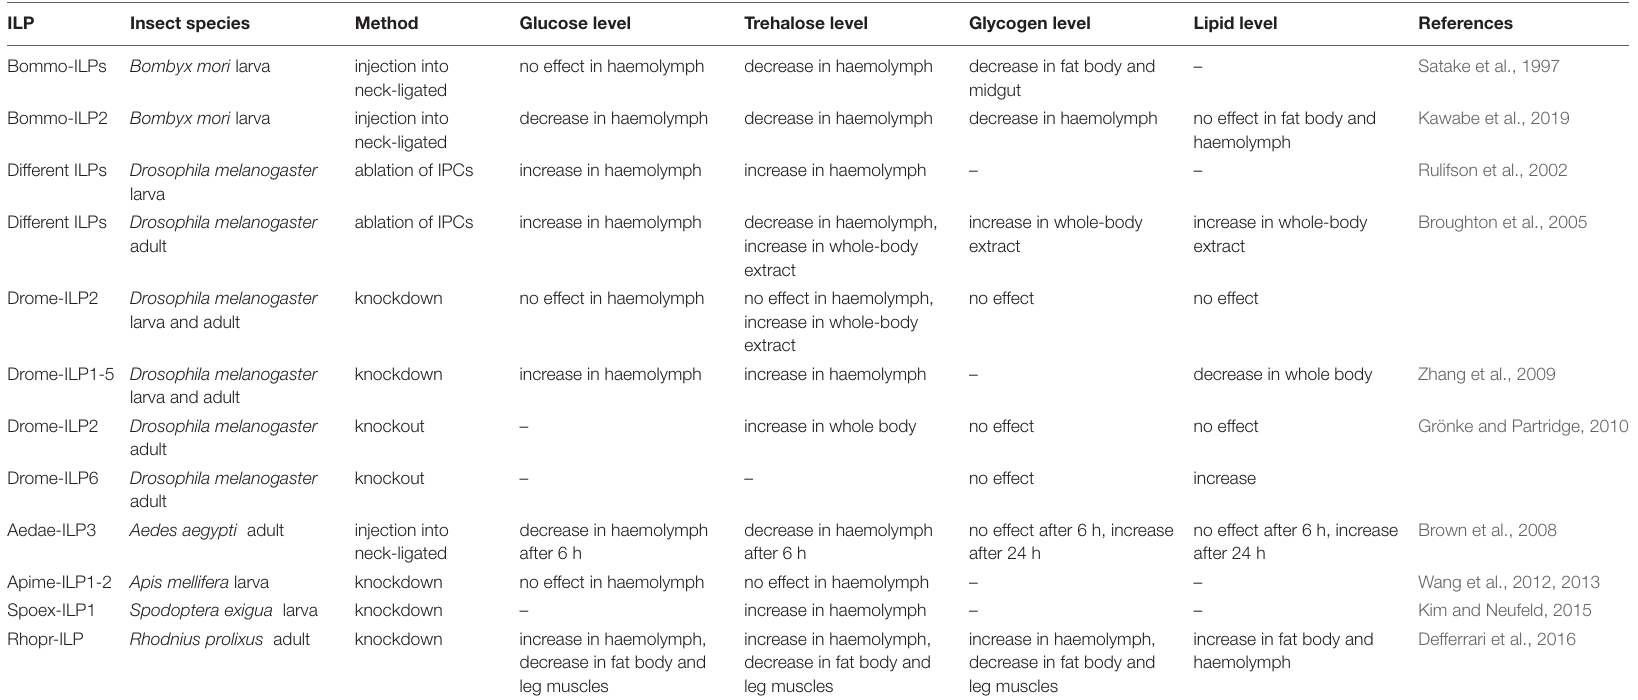
TABLE 2 | The effects of different ILPs on the level of energy substrates in insect